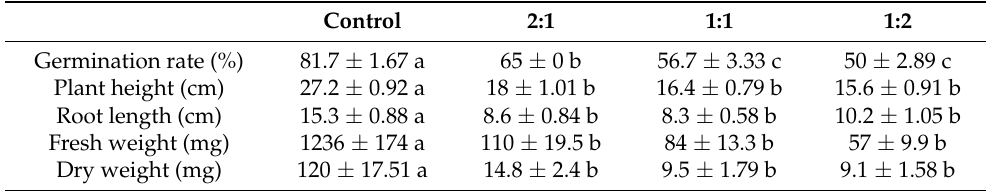
Table 2. Effect of Solanum carolinense dominance on the growth of Festuca arundinacea at different time intervals.